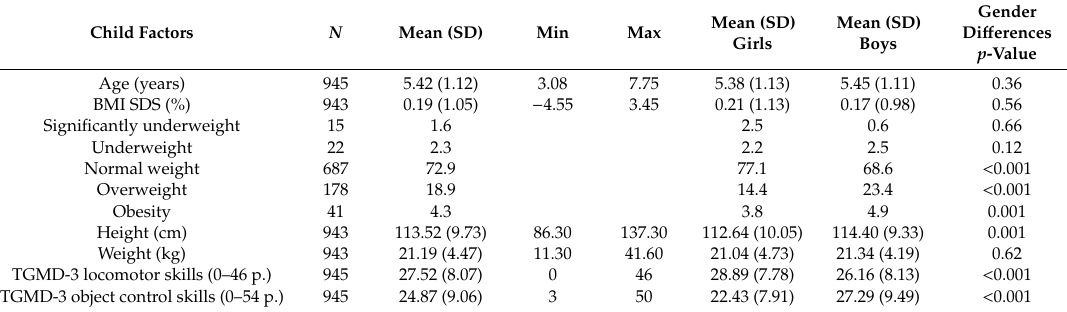
Table 2. The descriptive data of the study